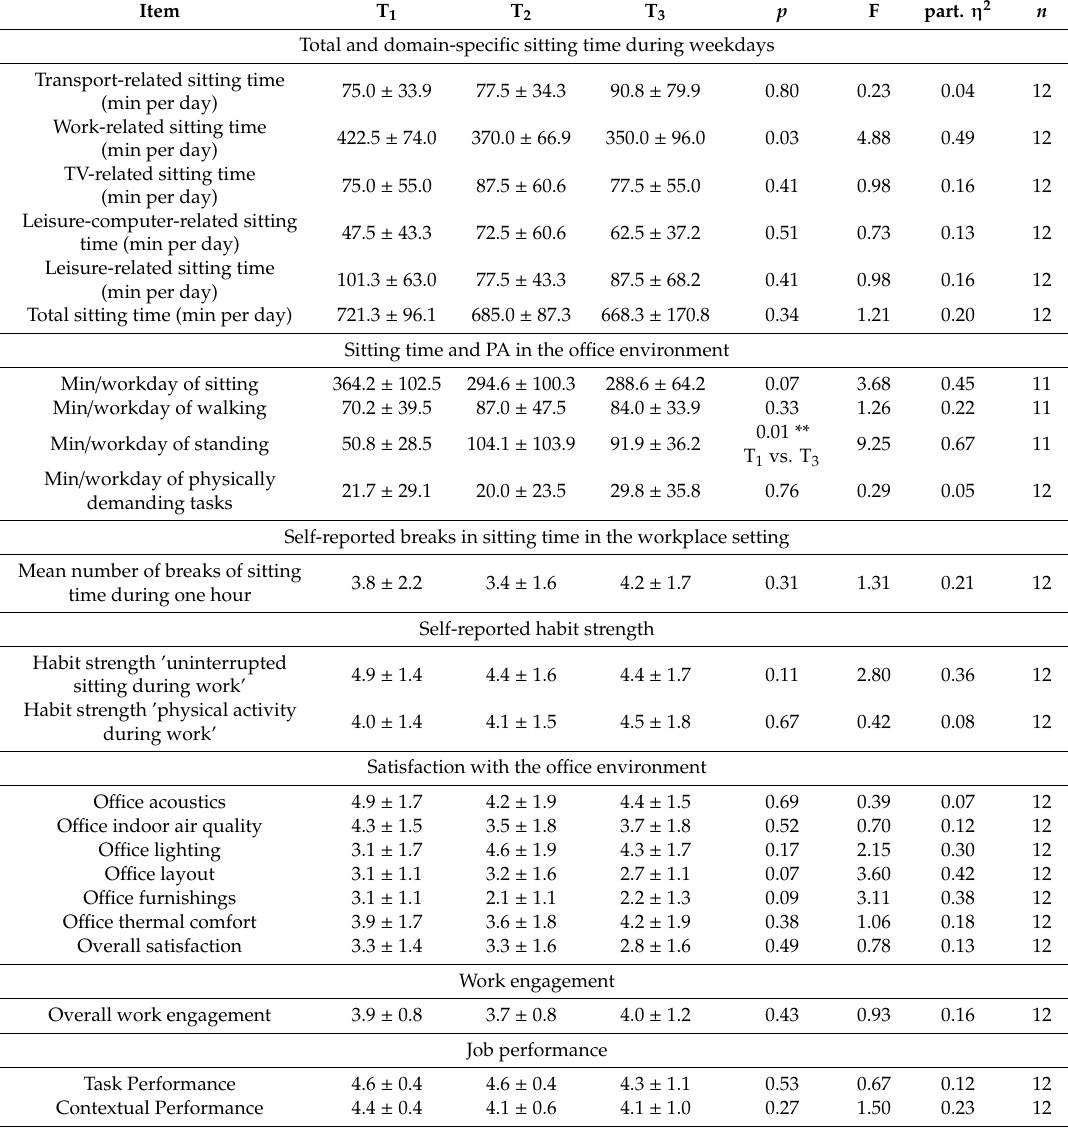
Table 2. Means, standard deviations (SDs) and statistical analyses of outcome variables at baseline (pre-location (T 1 ), three months after relocation (T 2 ), and seven months after relocation (T 3 )). Item T 1